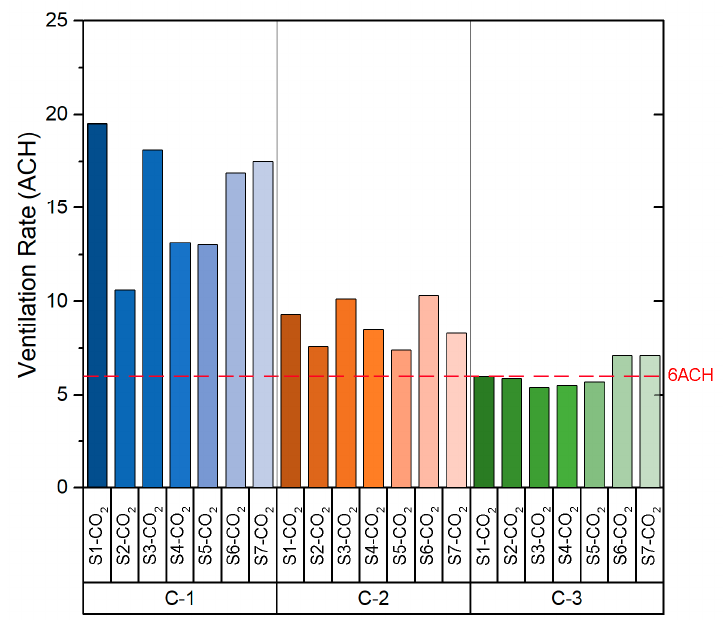
Figure 13. Ventilation rate (ACH) in Classroom B2-A2.